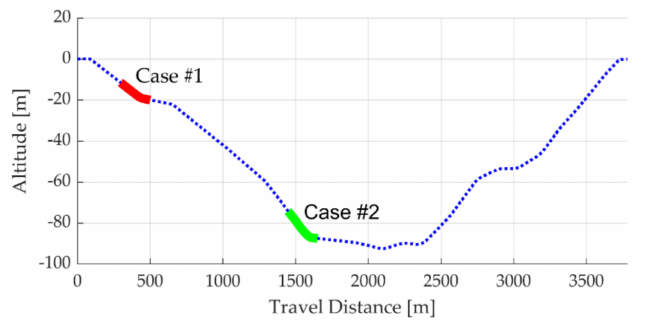
Figure 5. Altitude of reference path with Case #1 and Case